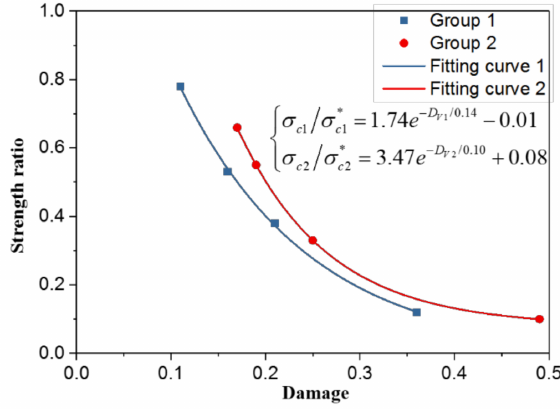
Figure 11. Strength ratio vs. damage of velocity.